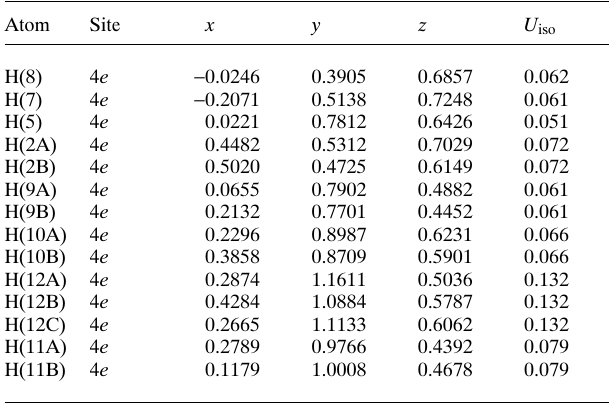
Table 2. Atomic coordinates and displacement parameters (in Å 2 )